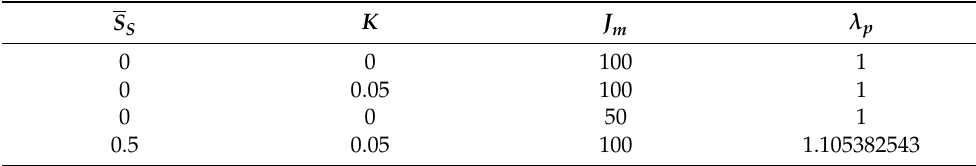
Table 1. The initial stretch of the MAP subjected to mechanical load